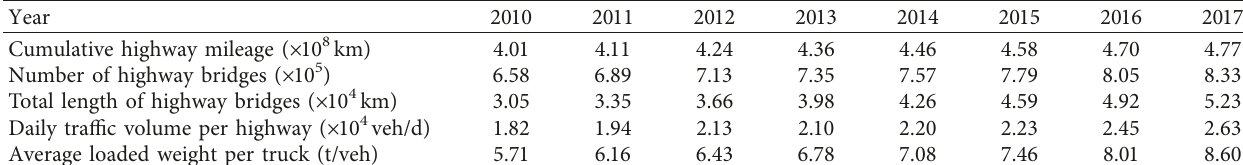
Table 1: China’s highway infrastructure development and concurrent traffic trends in 2010–2017